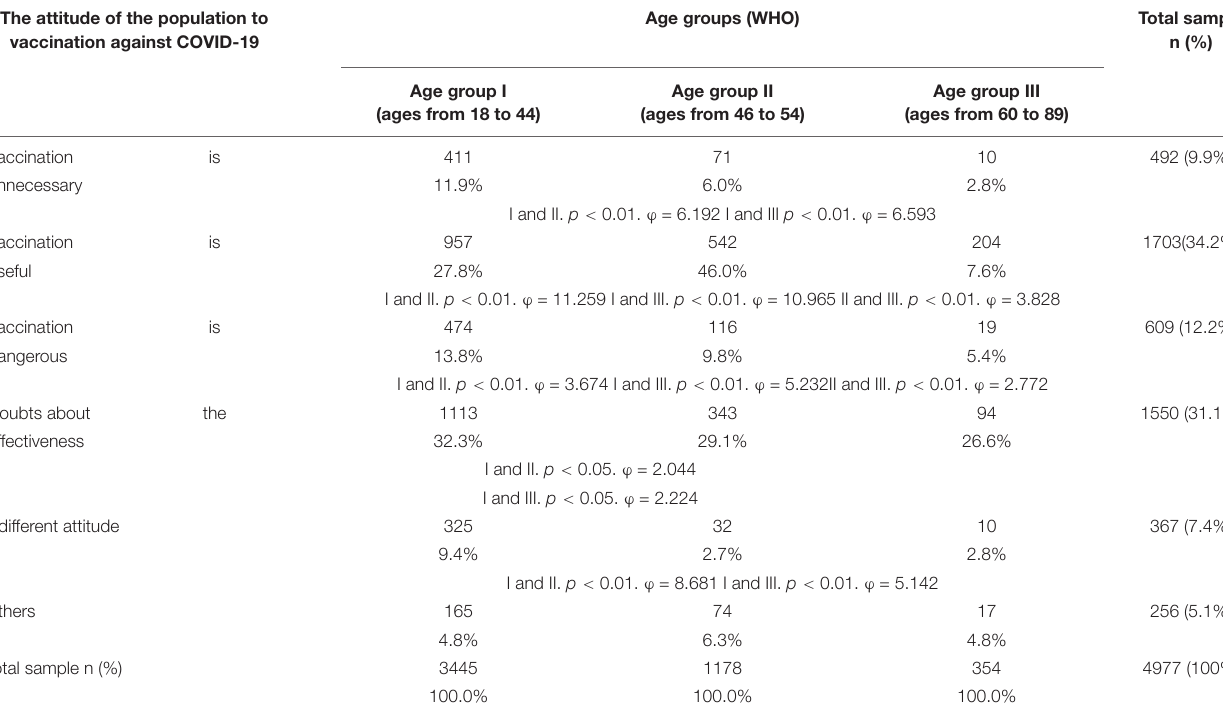
TABLE 2 | COVID-19 vaccination attitudes among different age groups. The attitude of the population to vaccination against COVID-19